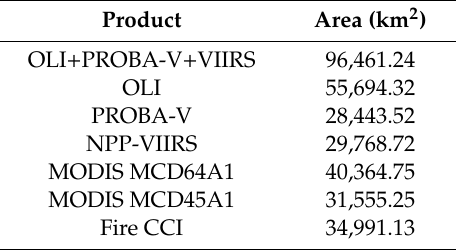
Table 4. Burned area estimated by the proposed method and by the global burned area